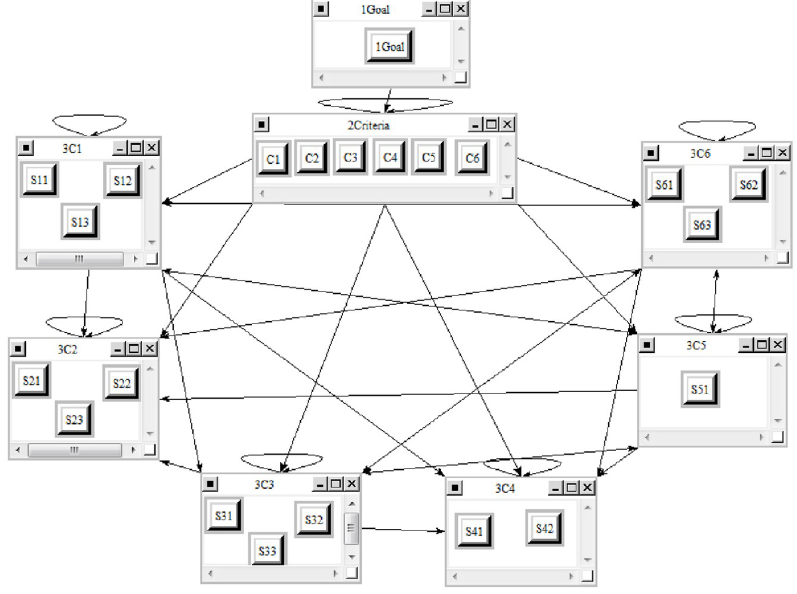
Fig 2. ANP graph, priority of the indexes and options in Super-Decision software identifying internal relationships of the main criteria.